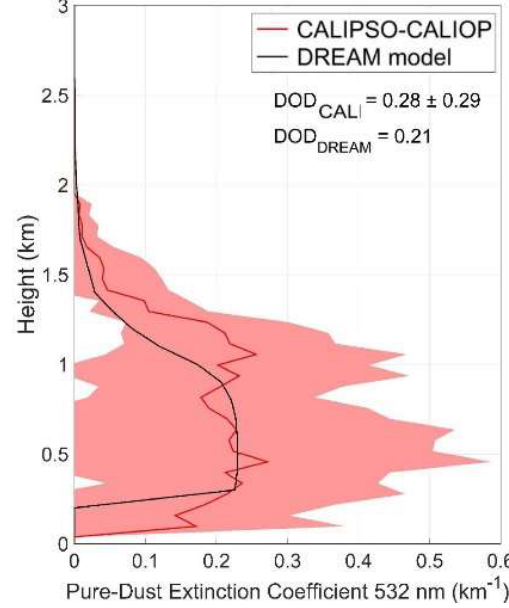
Figure 12. CALIPSO (CALIOP) (red line) and DREAM (black line) pure dust extinction coefficient at 532 nm vertical profiles averaged over the CALIPSO path for 12 September 2011. This dust event was captured by MODIS on 20 September 2018, showing at least 3 narrow dust plumes on the south coast of Iceland, visible both on true color and AOD lifted dust from the Landeyjarsandur and Markarfljót dust sources, and from the